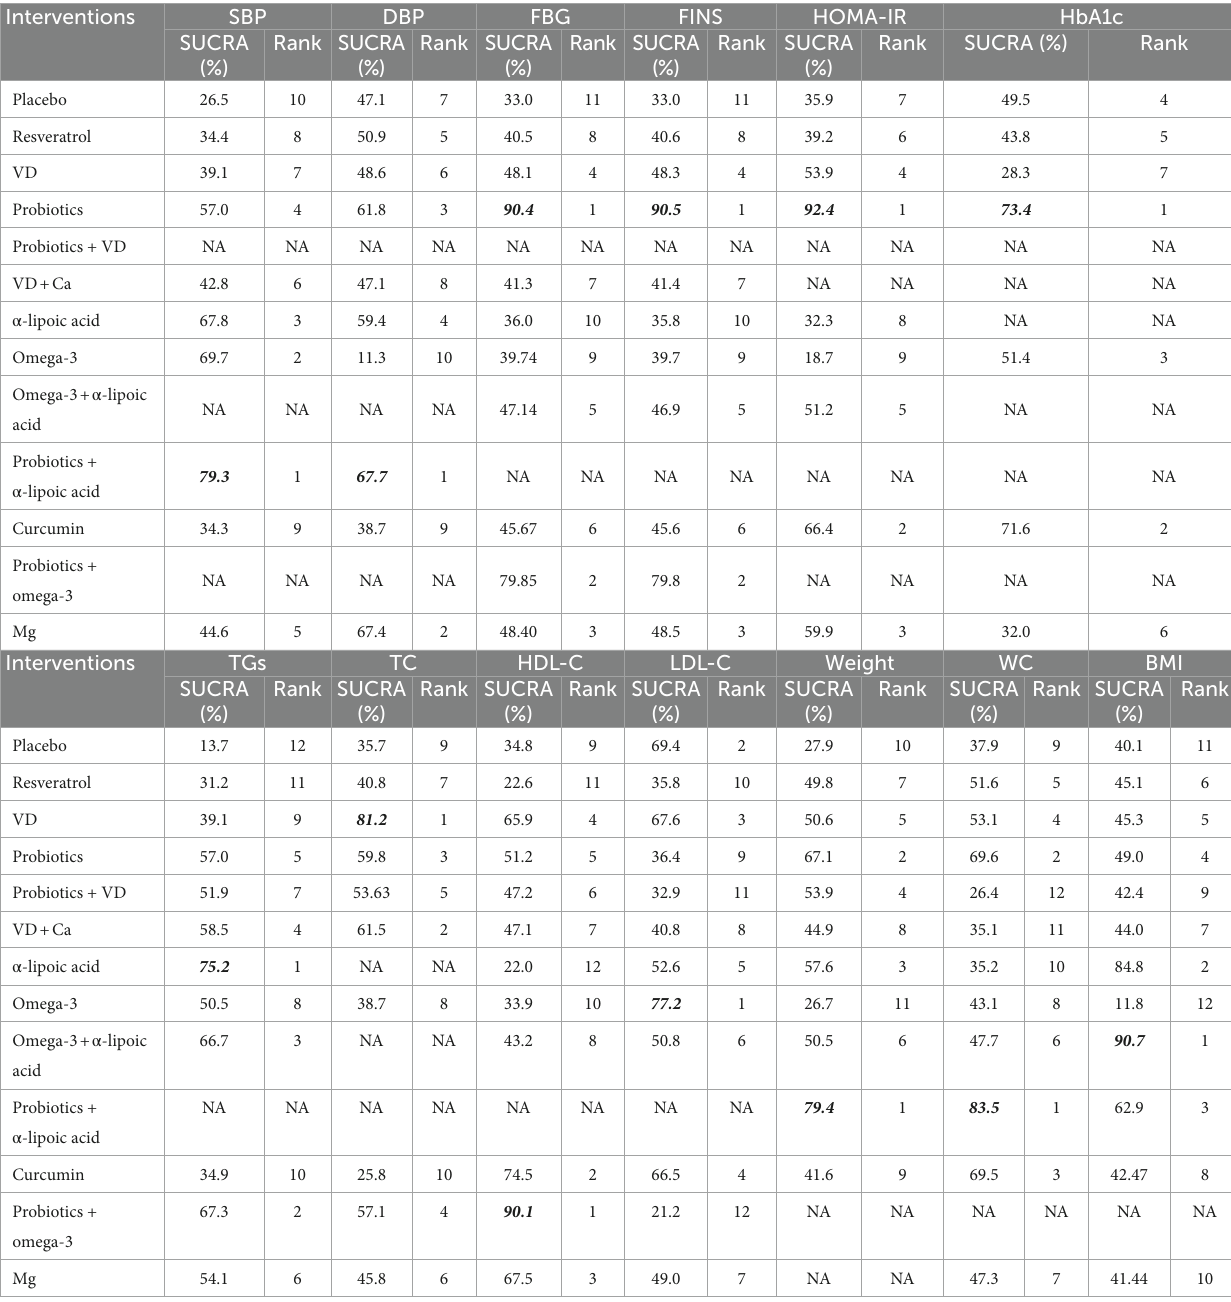
TABLE 2 Surface under the cumulative ranking curve and ranking probability of different nutrition supplements on each outcome. Interventions SBP